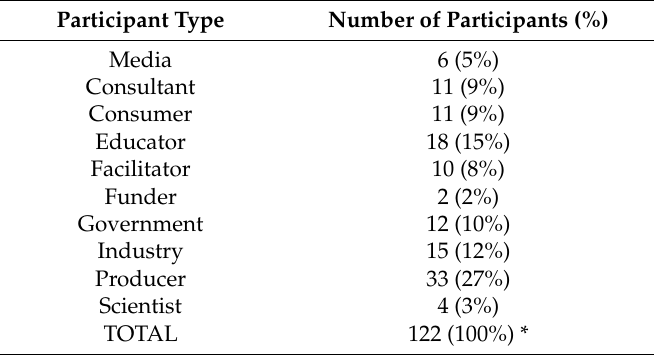
Table 1. Participant